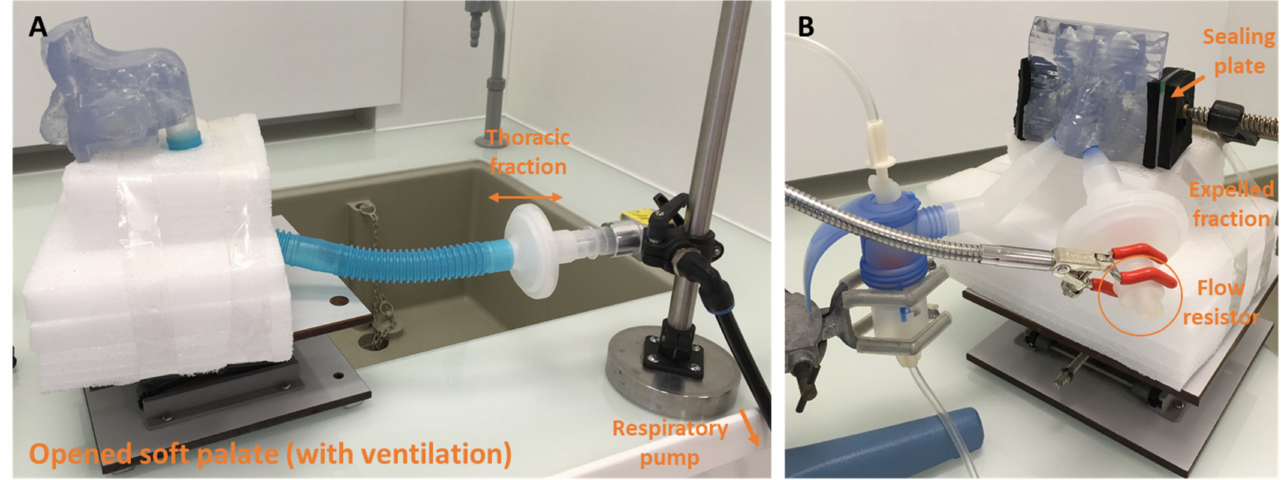
Figure 7. Experimental setup for NaF nebulization with PARI SINUS device in the opened soft palate condition. ( A ) The illustration shows the human nasal cast with open soft palate connected to the respiratory pump. The thoracic fraction was collected on a PARI filter 41B0523. ( B ) The nebulization duration was fixed at 6 min with sealing of maxillary sinuses (3 min in each nostril, whereas the other nostril was occluded with a flow resistor as the procedure recommended by the manufacturer for patient use). The expelled fraction was collected on a PARI filter